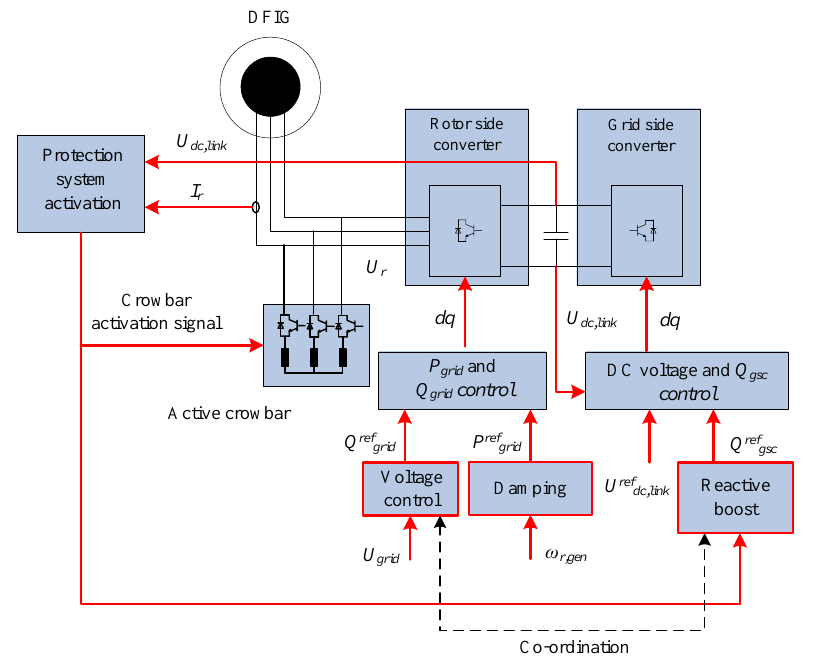
Figure 4. Control system of the DFIG wind turbine for FRT and voltage